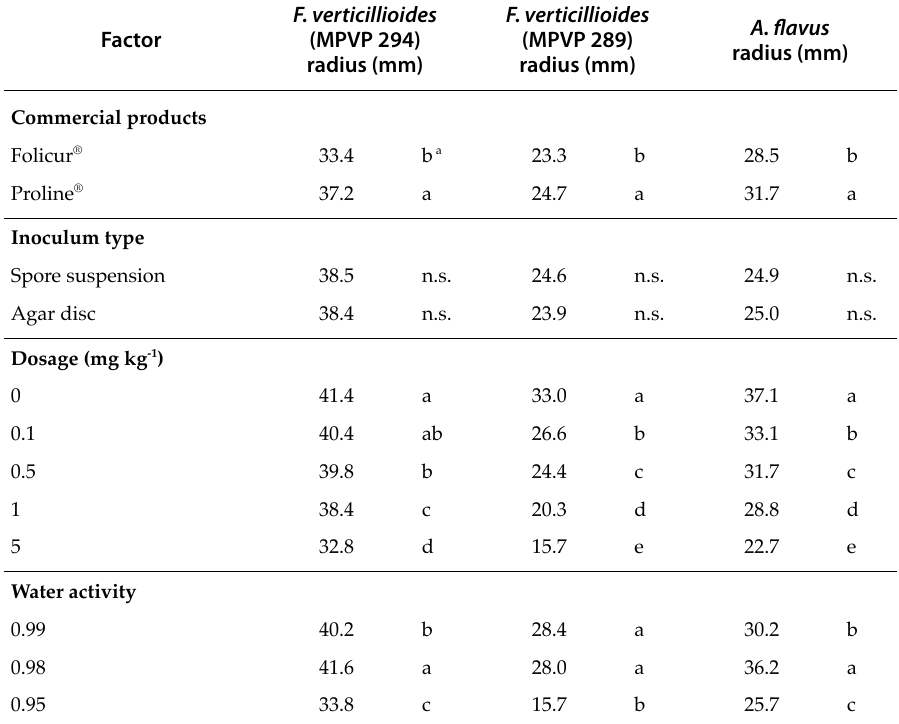
Table 1. Results of ANOVA regarding the effects of inoculation method, commercial fungicide products (Folicur ® and Pro- line ® ) and water activity (0.99, 0.98 and 0.95) on in vitro growth of Fusarium verticillioides (MPVP 294 and MPVP 289)